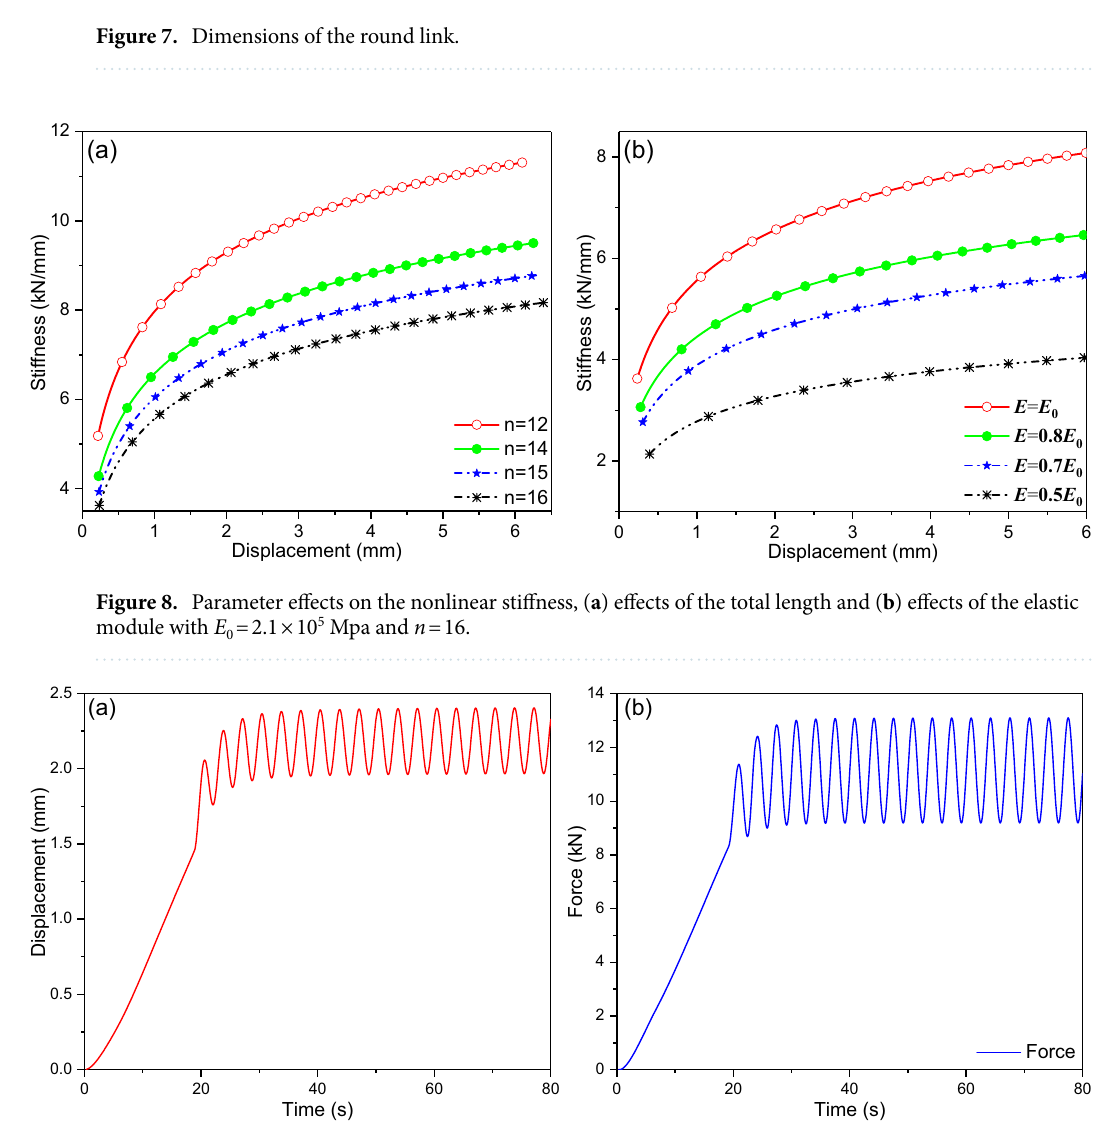
Figure 9. The loading and responses in time Figure 9a shows time-varying curves for the total displacement of the round link chain, and the dynamic force responses are measured with the force senor, as shown in Fig. 9b. With increment in the deformation of the round link chain, the nonlinearity is weakened. Overall, the frequency of the force responses keeps in agreement with that of the exciting displacement. This phenomenon and the variation of the stiffness to the displacement coincide mutually.